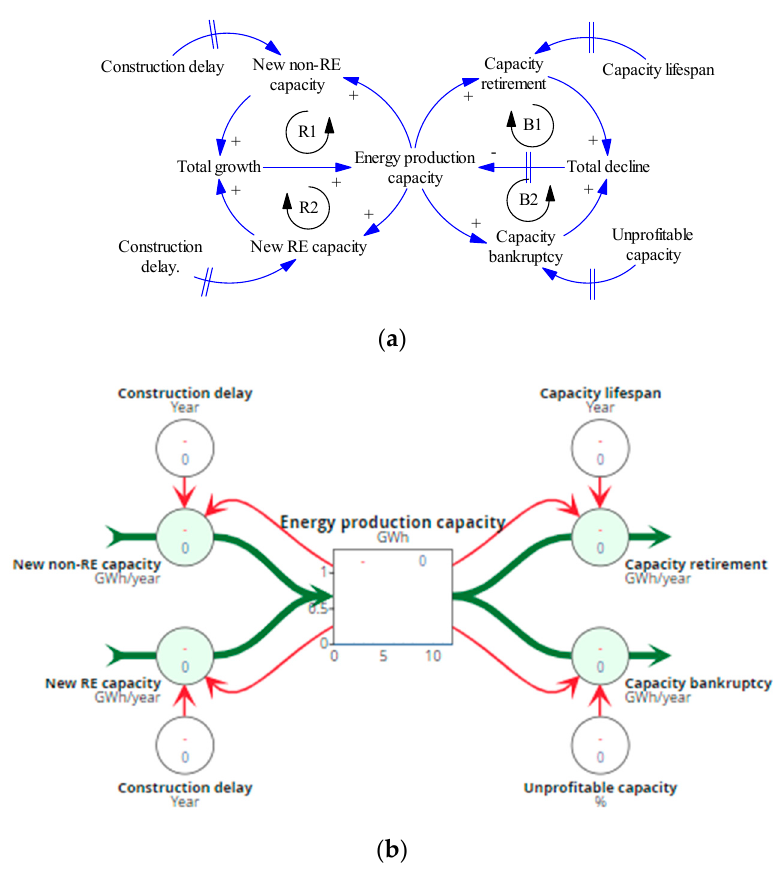
Figure 1. Feedback loops ( a ) and stock-flow model ( b ).